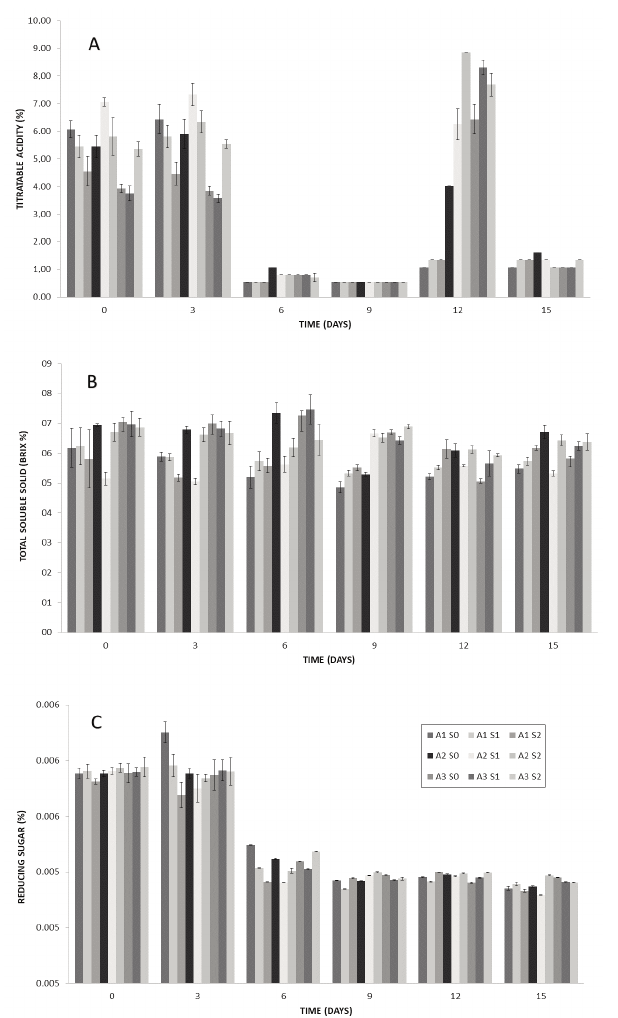
Fig. 3 - Effect of alginate based edible coating-betel essential oil on TA (A), TSS (B) and RS (C) of rose-apple cv. Dalhari.